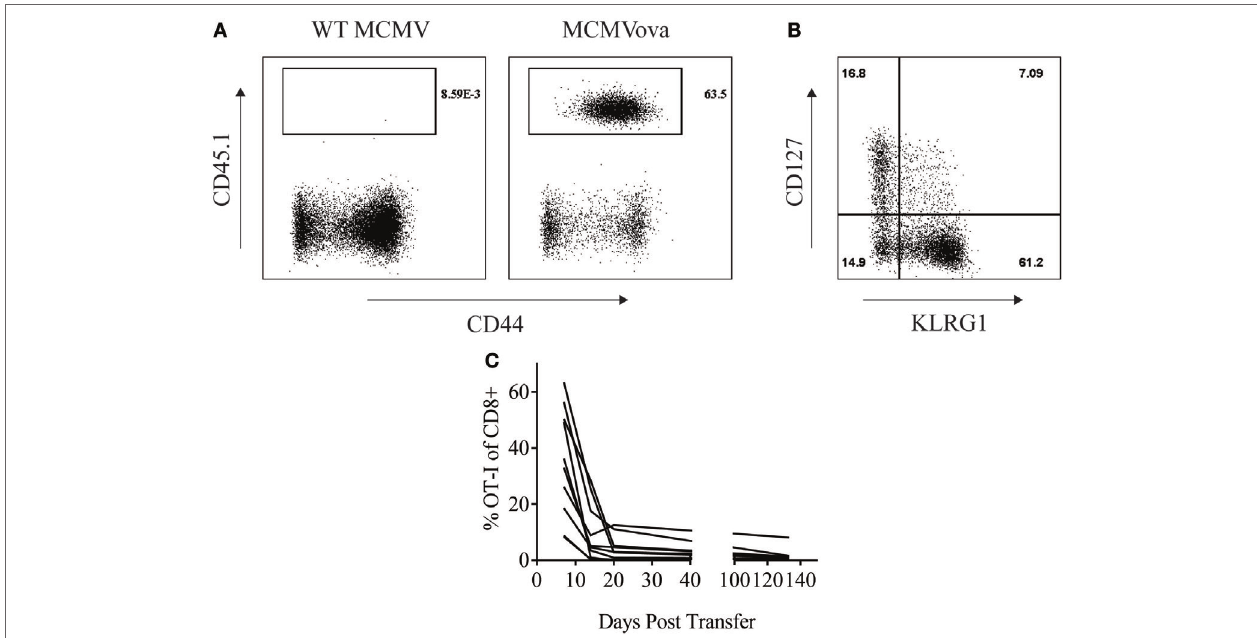
FigUre 1 | Murine cytomegalovirus (MCMV)-OVA maintains adoptively transferred OT-I cells at low frequency long-term. Wild-type (WT) CD45.2 + mice received 10 5 CD45.1 + OT-I cells i.v. followed by i.p. vaccination with 10 5 WT MCMV or MCMV-OVA. Peripheral blood was collected at various time points after transfer and processed for flow cytometry. (a) Representative plots from peripheral blood of mice receiving OT-I transfer and vaccination with WT MCMV or MCMV-OVA 7 days prior. Gated on CD8 + cells. (B) Representative plot showing phenotype of OT-I cells from mice vaccinated with MCMV-OVA 7 days prior. Gated on CD8 + CD45.1 + cells. (c) Frequency of CD45.1 + of CD8 + cells over time in peripheral blood of mice vaccinated with MCMV-OVA. Each curve is representative of one mouse. Data are accumulated from two independent experiments with 10 mice/group